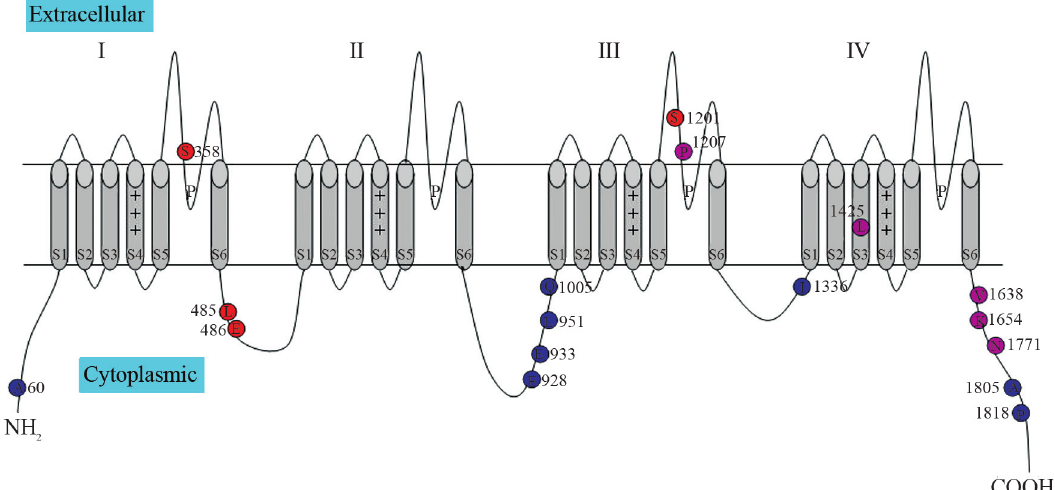
Figure 2 - Two-dimensional structure of the rat Na v 1.4 channel. A sodium channel is composed of four domains (I – IV), each consisting of six transmembrane segments (S1-S6). The (cid:3) -helical S4 segment, which possesses many positive charges, is the voltage sensor. The P-loops between the S5 andS6segmentsofeachdomainfaceeachother,thusformingaporethatistheoutermouthofthechannel.TheloopbetweendomainsIIIandIVisthein- nermouthofthechannel.Cylindersindicatetransmembrane (cid:3) -helices,whereaslinesrepresentthehydrophilicportionsofthechannel.Pink,blueandred amino acids represent positively selected sites identified in the pufferfish, garter snake and mammalian lineages, respectively (for detail see Figure 1). Numbering of the amino acids is according to the rat Na v 1.4 protein sequence